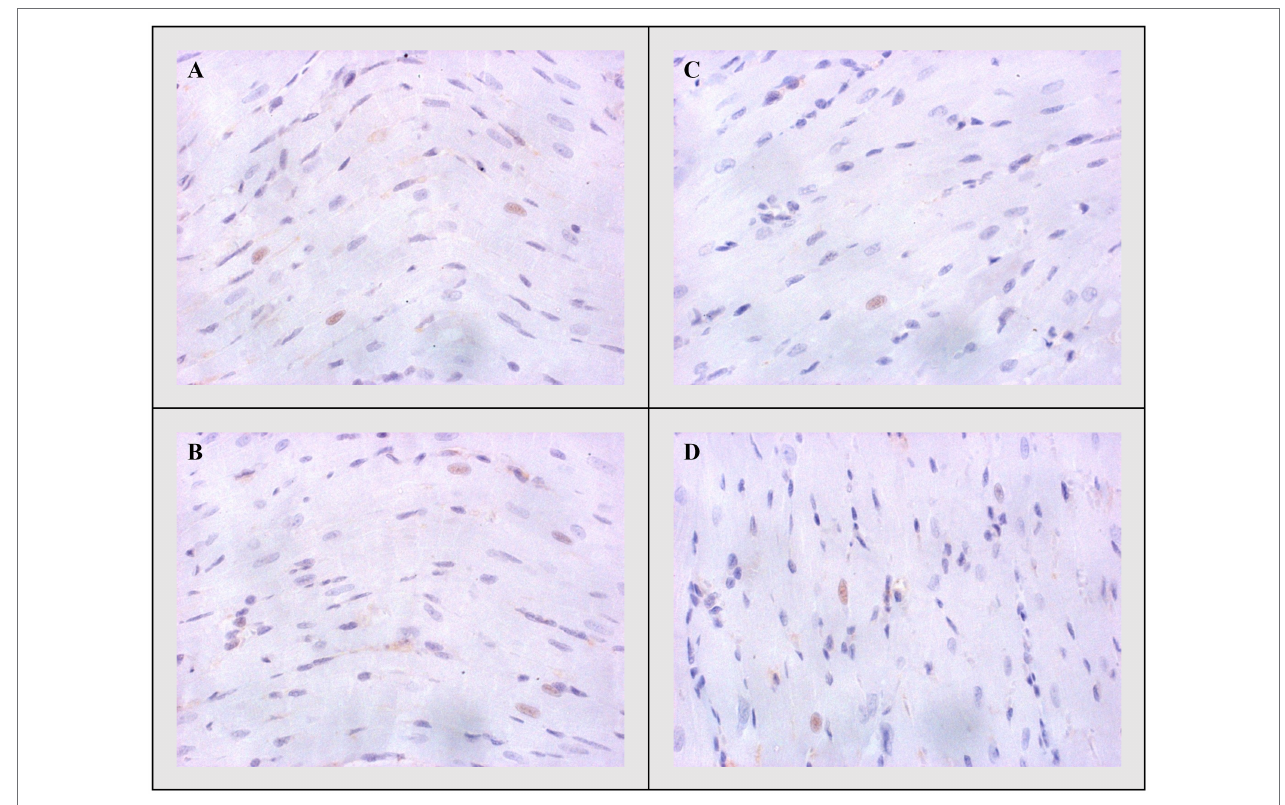
FIGURE 6 | Representative heart tissue sections of immunohistochemical staining of Bcl-2. (A) CTRL, (B) THIA, (C) DOX, and (D) DOX + THIA. Original magnification 20 ×